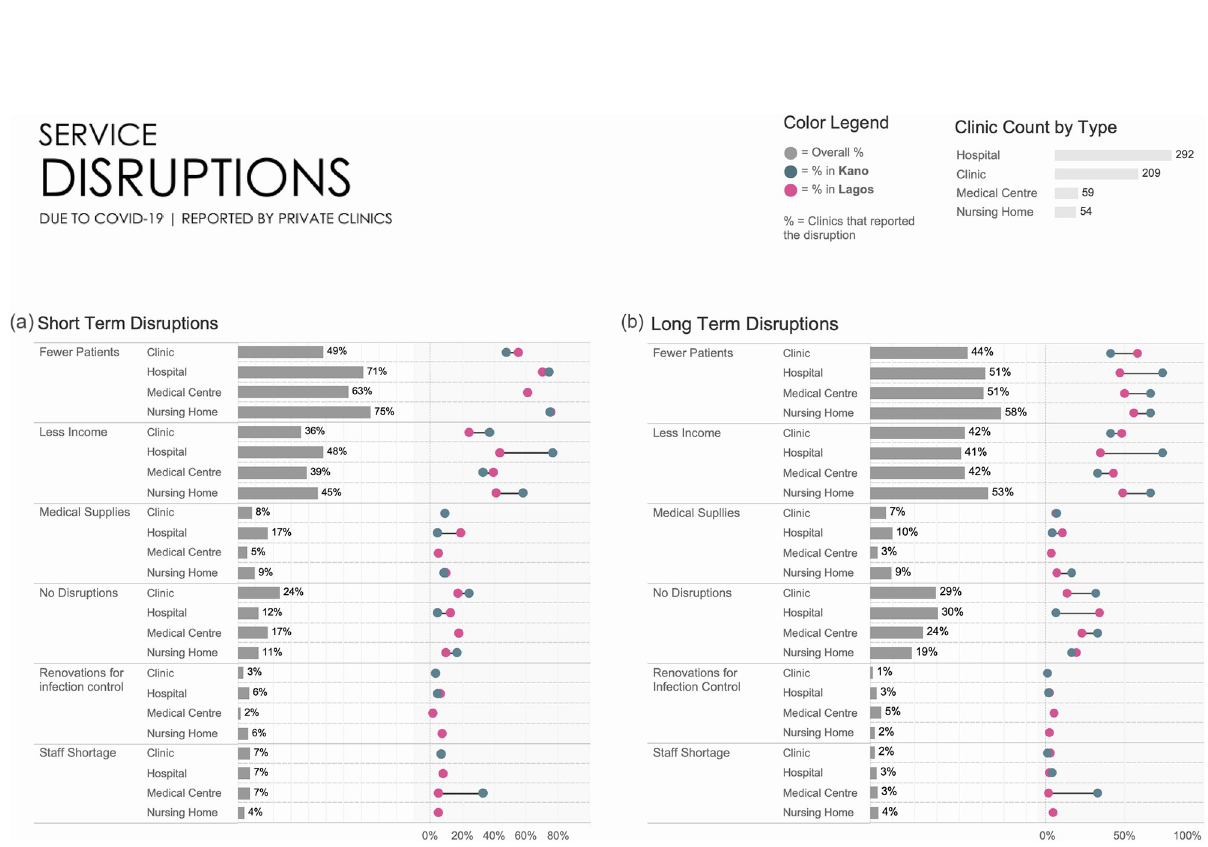
Fig 4. (a) Availability of TB screening services across facility type and location in Q2 2021; (b) COVID-19 screening services across facility type and location in Q2 2021.